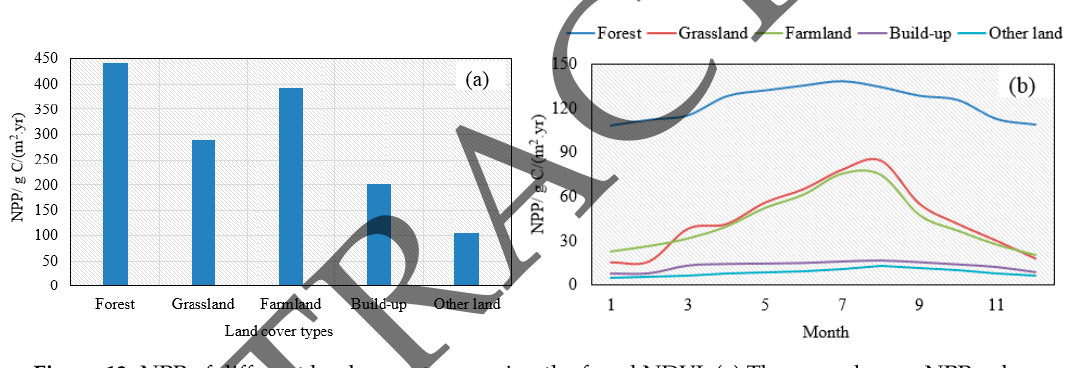
Figure 13. NPP of different land cover types using the fused NDVI. ( a ) The annual gross NPP value and ( b ) the monthly NPP value.